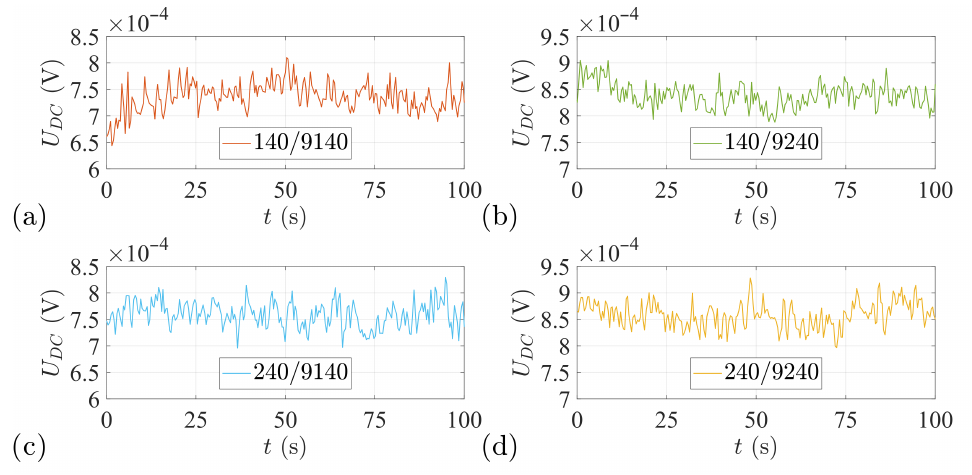
Figure 13. Voltage U DC measured for 10 W of output power at load R0: ( a ) 140/9140; ( b ) 140/9240; ( c ) 240/9140; and ( d ) 240/9240 transistor